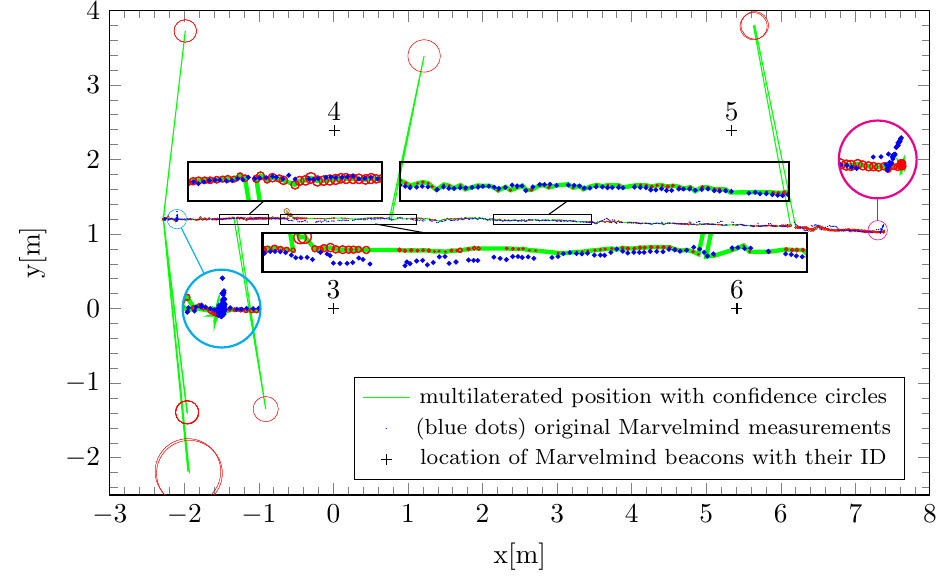
Figure 15. Lateral motion tracking after